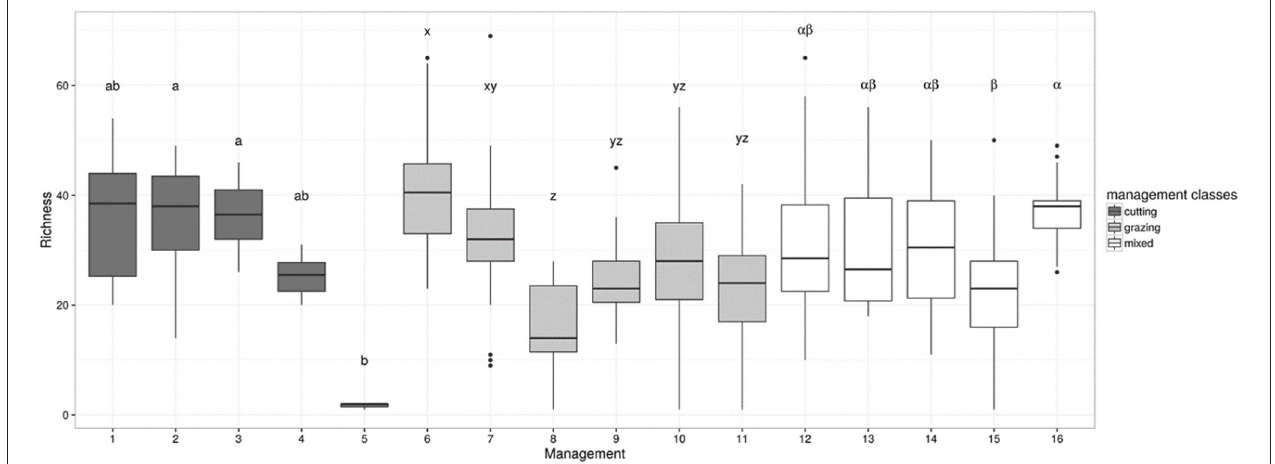
FIGURE 3 | Indicator of grassland suitability for butterflies (species richness index = y-axis) assessed for a set of 395 French grasslands under contrasting management regimes, as described in Table 1 , i.e., (1): one cut per year, (2): two cuts per year for low-yield grasslands, (3): three or more cuts per year for low-yield grasslands, (4): two or three cuts per year for high-yield grasslands, (5): four or more cuts per year for high-yield grasslands, (6): continuous grazing at a low stocking rate, (7): continuous grazing at a medium stocking rate, (8): continuous grazing at a high stocking rate, (9): rotational grazing with long rotations, (10): “ecological” rotation with some subplots ungrazed at flowering peak, or late grazing during autumn only, (11): rotational grazing with short rotations, (12): one cut followed by continuous grazing at a low or medium stocking rate, (13): one cut followed by continuous grazing at a high stocking rate, (14): one cut followed by rotational grazing with long rotations, (15): one cut followed by rotational grazing with short rotations, (16): two cuts before grazing. Within each management type, i.e., cutting vs. grazing vs. mixed, means with different letters were significantly different at P < 0.05. Background color of the boxes denotes management classes: cutting (black), grazing (gray), and mixed (white).